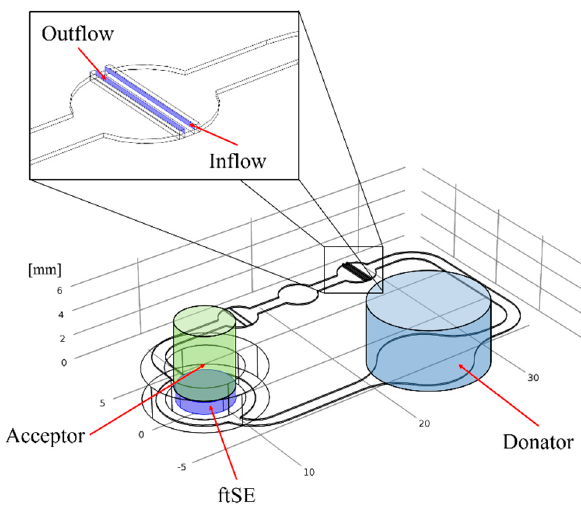
Figure 5. Geometry of the numerical simulation. The green cylinder shows the volume of the acceptor, and the blue cylinder shows the volume of the donator. At the bottom of the acceptor the ftSE is located. The zoom shows the position of the in- and outflow for the fluid simulation.